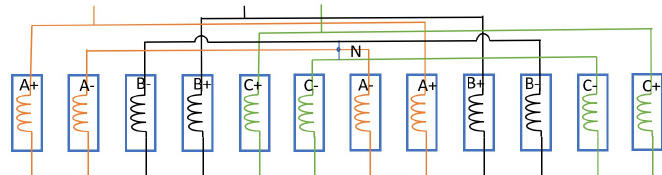
Figure 4. Winding disposition and connection. For this prototype machine, both parallel connection and Y connection is made outside the housing through six connection terminals.